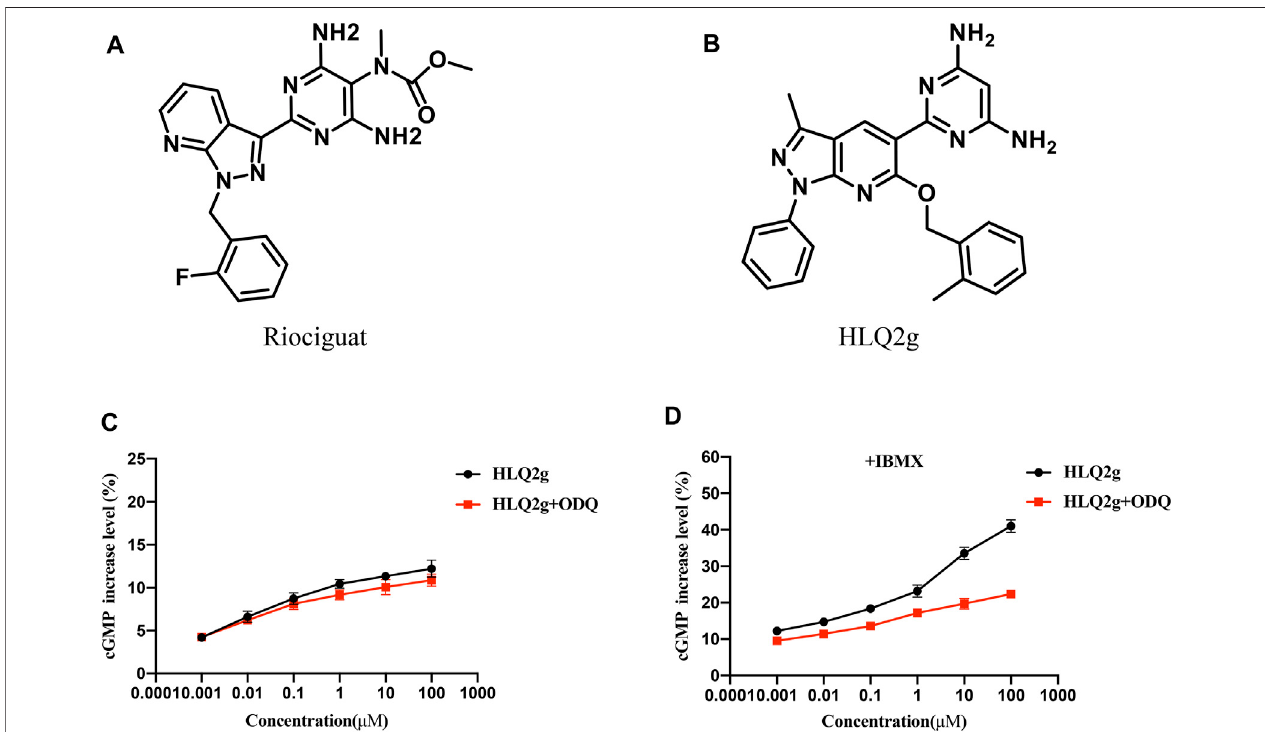
FIGURE1| HLQ2gcanstimulatesGCandupregulatecGMP. (A) :ThestructureofRiociguat. (B) :ThestructureofHLQ2g. (C) :Dose-dependentcurveofHLQ2gto elevate the cGMP levels in the absence or presence of 10 μ M ODQ in HPASMCs without IBMX, values are the average of three independent experiments. (D) : Dose- dependentcurveofHLQ2gtoelevatethecGMPlevels intheabsenceorpresenceof10 μ MODQinHPASMCs underconditionofIBMX(10 μ M),valuesaretheaverage of three independent